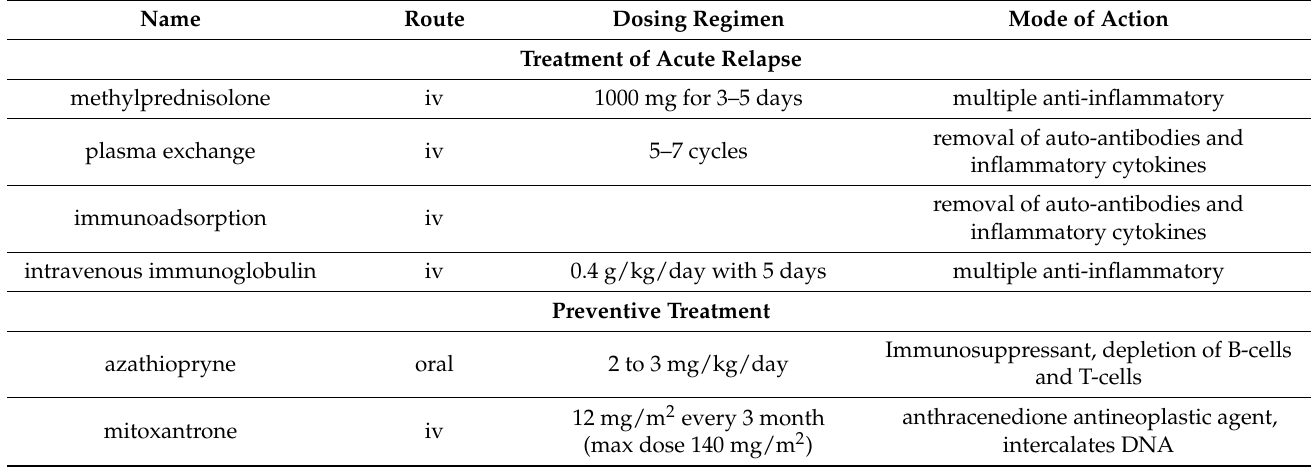
Table 2. Currently available therapies for NMOSD. (* drugs approved by FDA/EMA)